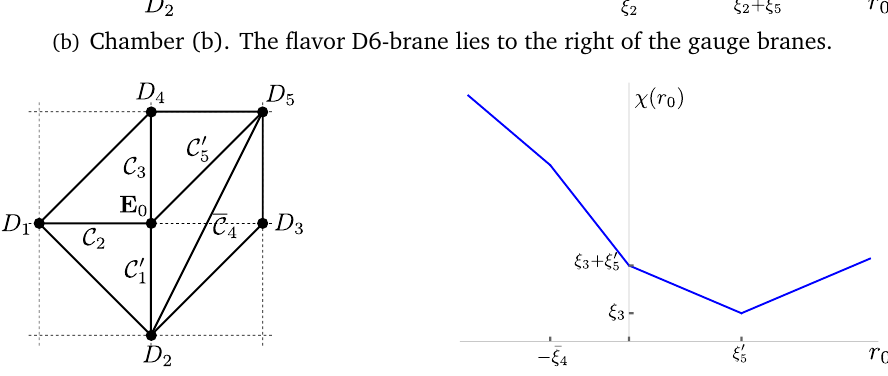
Figure 10: The three resolutions of the E the corresponding IIA profiles for χ ( r